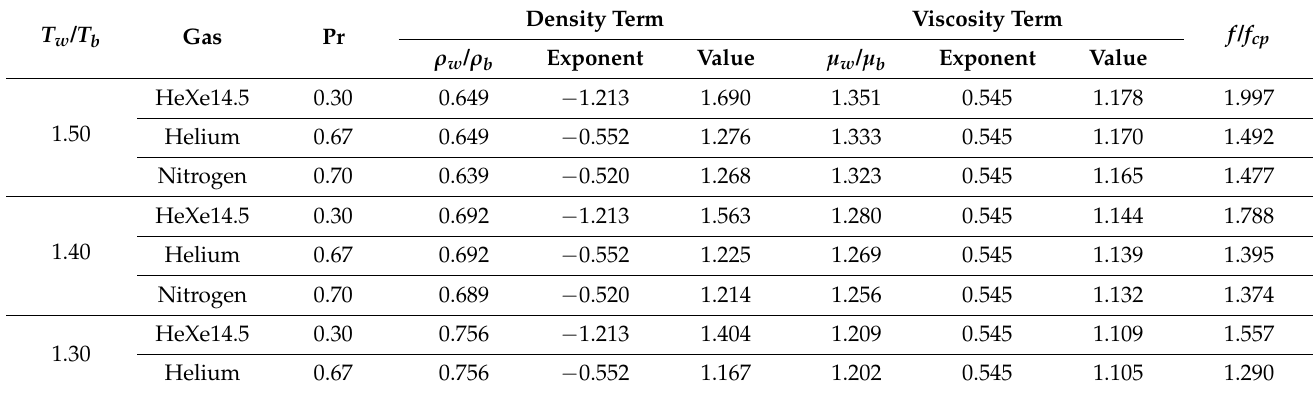
Table 10. Analysis of impact factors of property-variable laminar flow f .